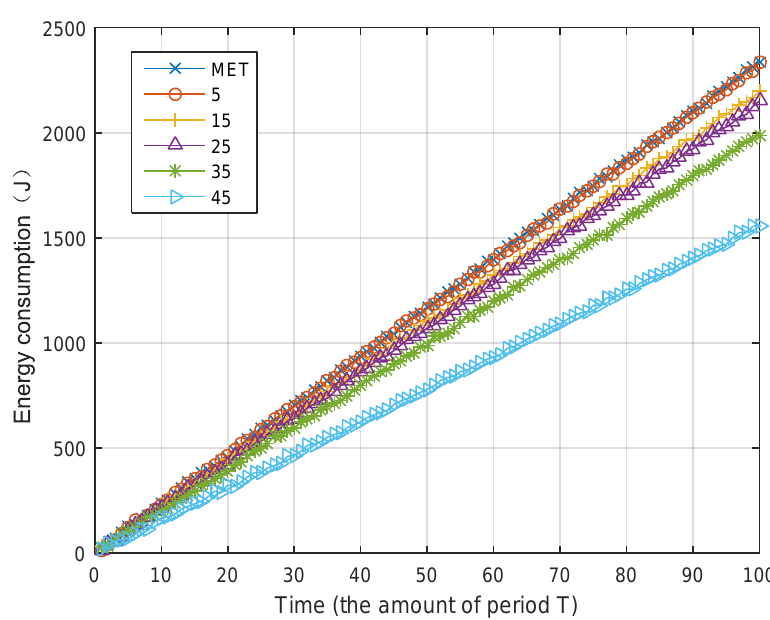
Figure 5. Energy consumption increasing with